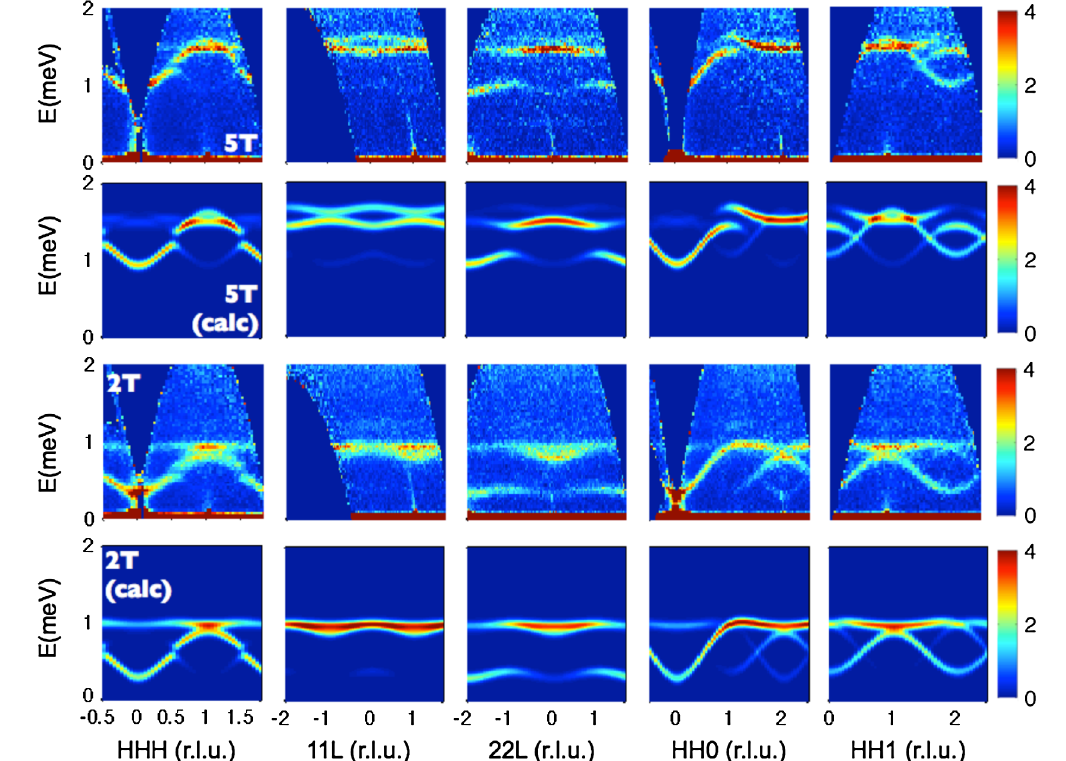
FIG. 1. The measured S ð Q ; ! Þ at T ¼ 30 mK , sliced along various directions in the HHL plane, for both H ¼ 5 T (first row) and H ¼ 2 T (third row). The second and fourth rows show the calculated spectrum for these two field strengths, based on an anisotropic exchange model with five free parameters (see text) that were extracted by fitting to the 5 T data set. For a realistic comparison to the data, the calculated S ð Q ; ! Þ is convoluted with a Gaussian of full-width 0.09 meV. Both the 2 T and 5 T data sets, composed of spin wave dispersions along five different directions, are described extremely well by the same parameters. (Note that r.l.u. stands for reciprocal lattice units.)